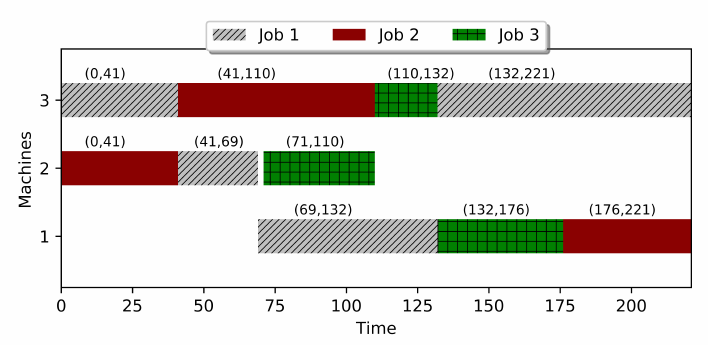
Figure 4. The optimal solution for the problem instance in Table 1; blocking CJSS problem.